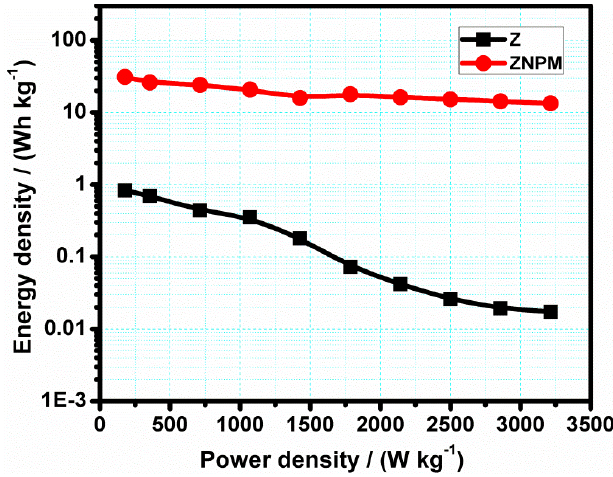
Figure 8. Power density vs. energy density of the Z and ZNPM hybrid electrodes.